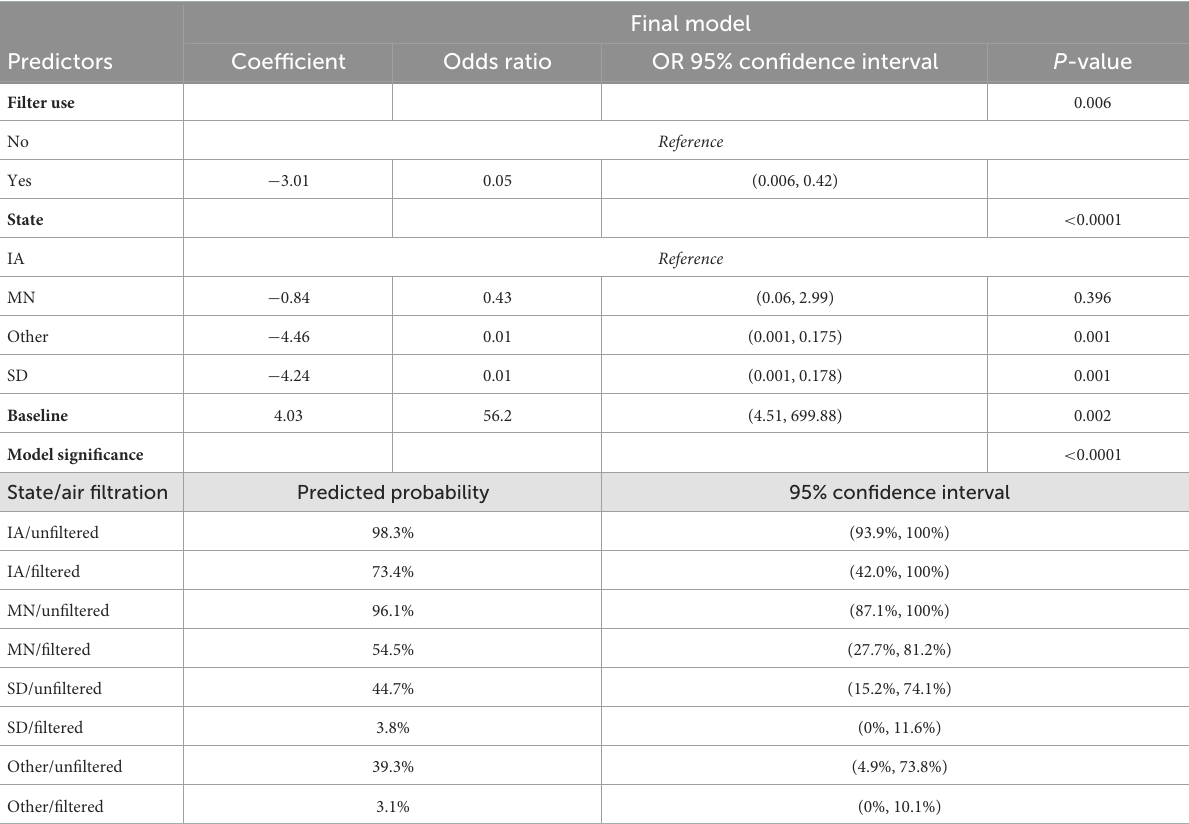
TABLE 2 Logistic regression coefficients and odds ratio in comparing PRRSV-infected sites to uninfected sites in the Pipestone Management System from January 2020 to January 2022.